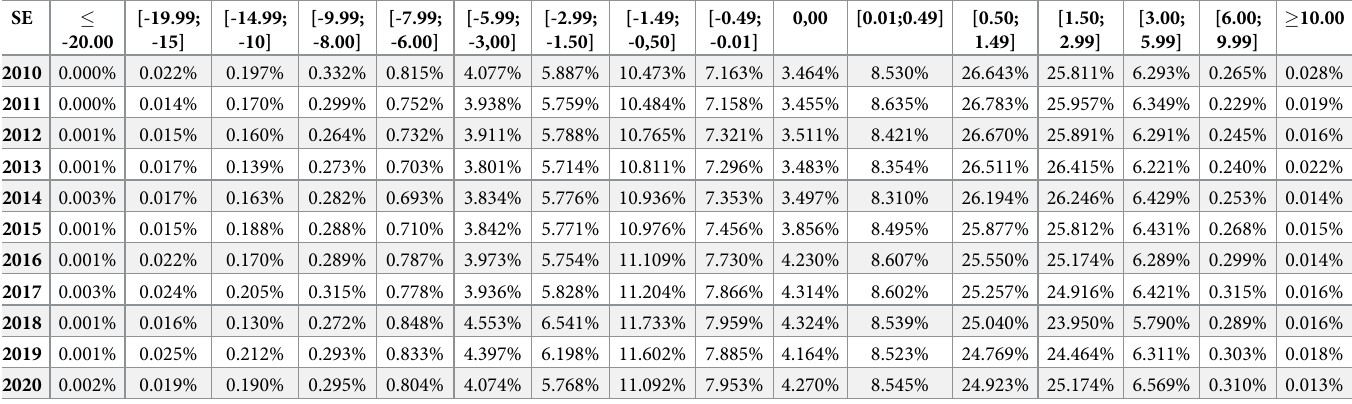
Table 2. Total percentage values according 14 spherical equivalent (SE) ranges for the progressive/multifocal prescriptions group.